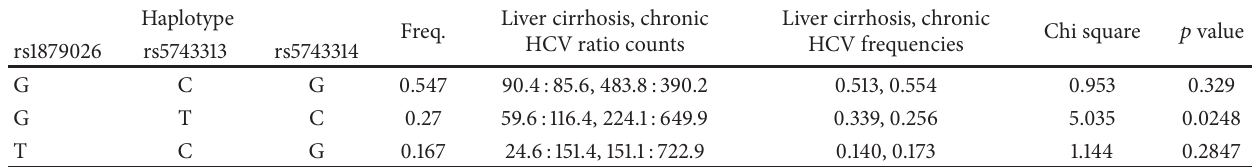
Table 6: Haplotype frequencies of TLR3 SNPs in chronic HCV-infected patients compared to patients with liver cirrhosis. Haplotype Freq.